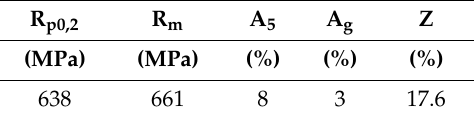
Table 3. Mechanical properties of W-1RS-160 / 21 specimen.